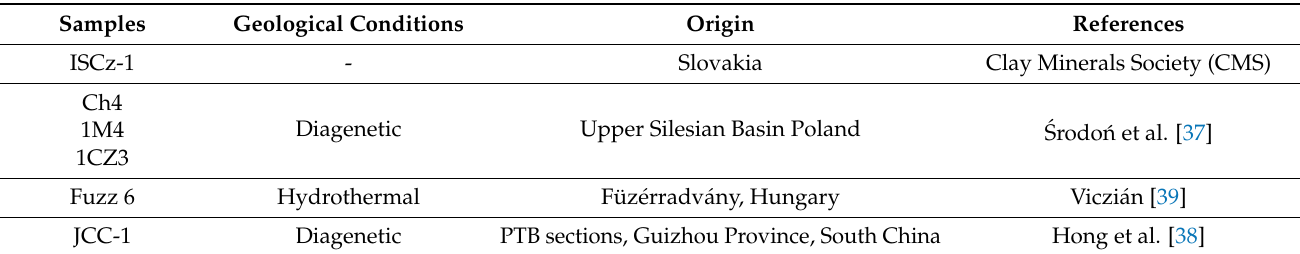
Table 1. Samples